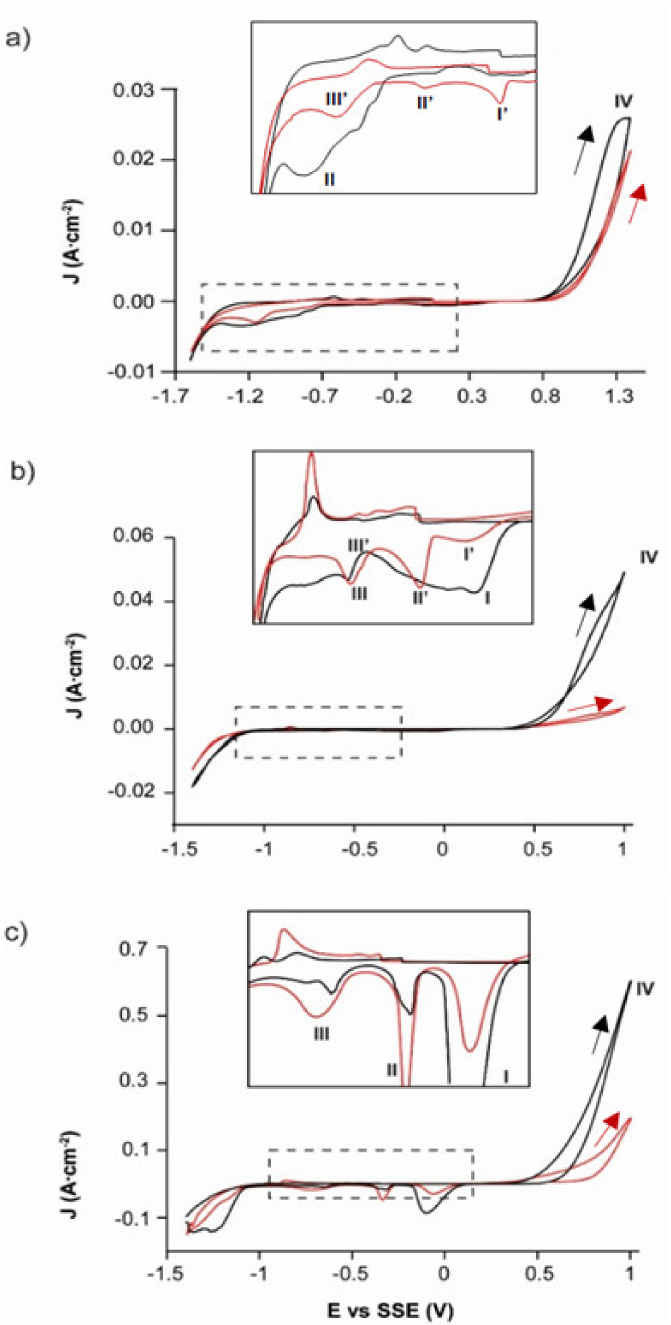
Figure 1. Typical CPE-ZnS voltamperograms (70:30 wt.%) obtained at a scan speed of 100 mVs − 1 and positive direction. ( a ) 0.1 M Na 2 SO 4 , pH = 7; ( b ) 0.1 M H 2 SO 4 , pH = 2; ( c ) 1.7 M H 2 SO 4 . EAHSS, red line; EBHSS, black line. Full line squares show the detailed redox processes of the samples indicated in dashed